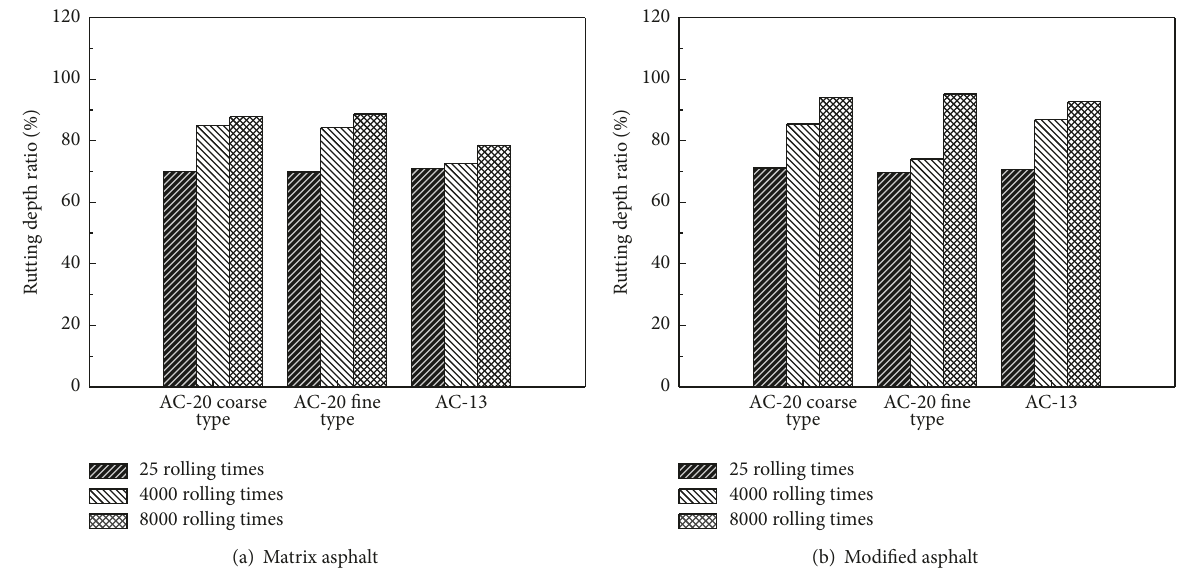
Figure 13: Rutting depth ratios of specimens with 7% air void at 50 ∘ C under different rolling